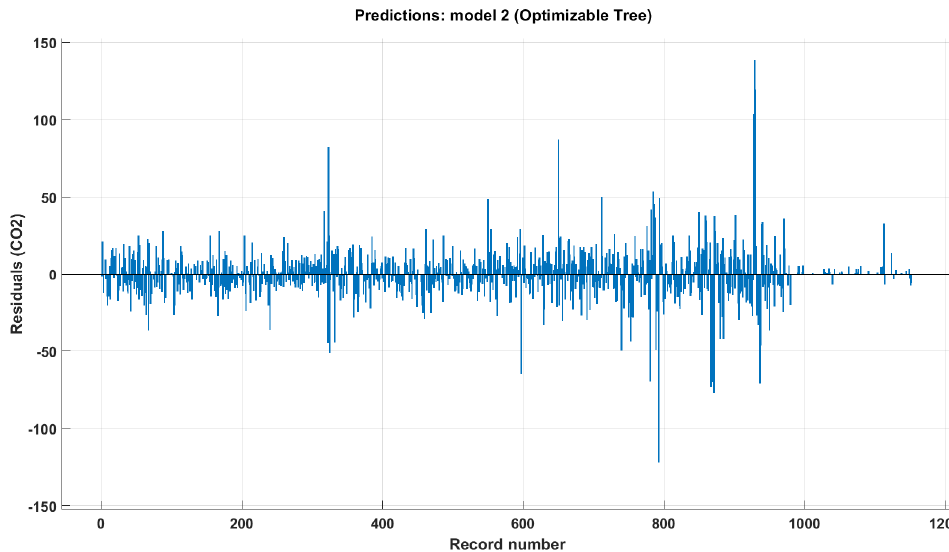
Figure 14. The Bi-cluster formation from QU-H10 and QU-C05 data captured during 8 h from CO2 and Temperature Variables. The OBRM3 Response for CO2 (ppm).